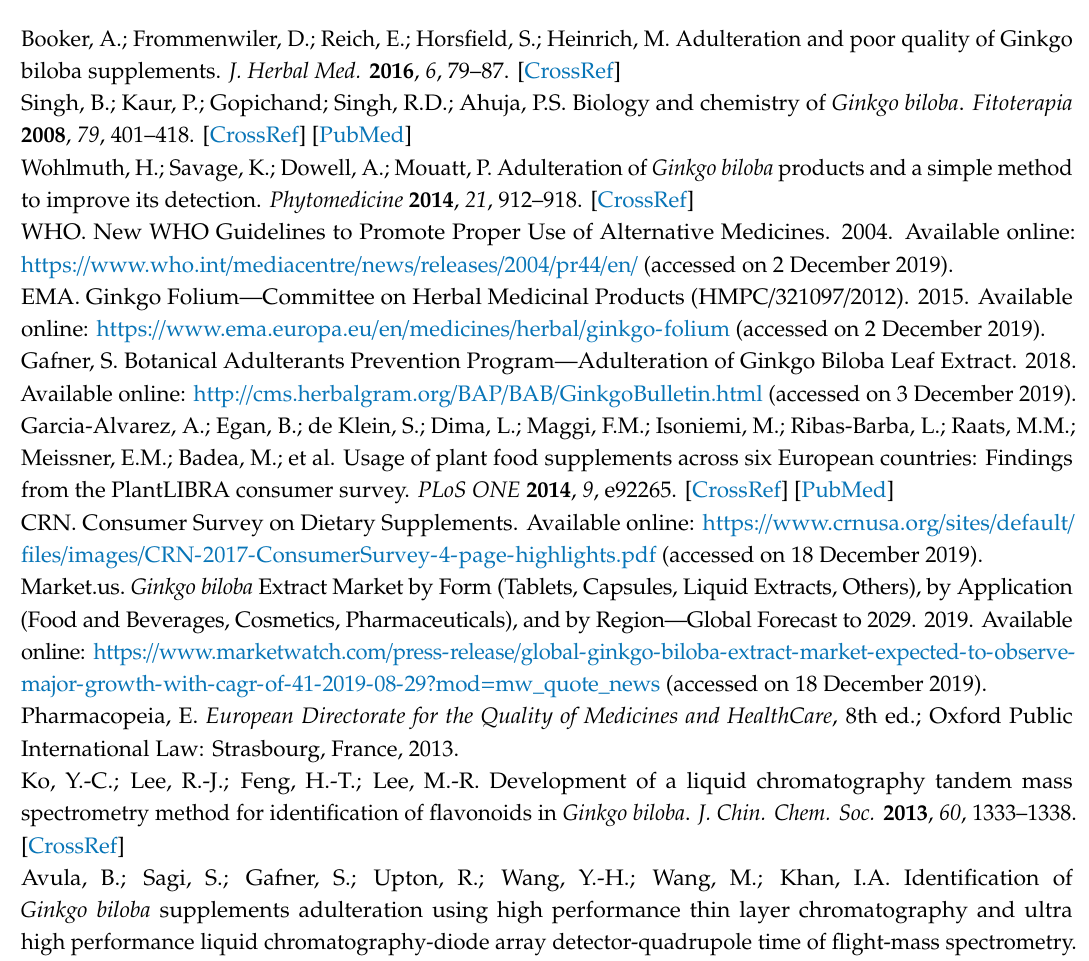
Table S1: Results of cross-reactivity testing of ITS1 primers are presented. Figure S1: Sensitivity by qualitative PCR. Figure S2: Analytical specificity by real-time